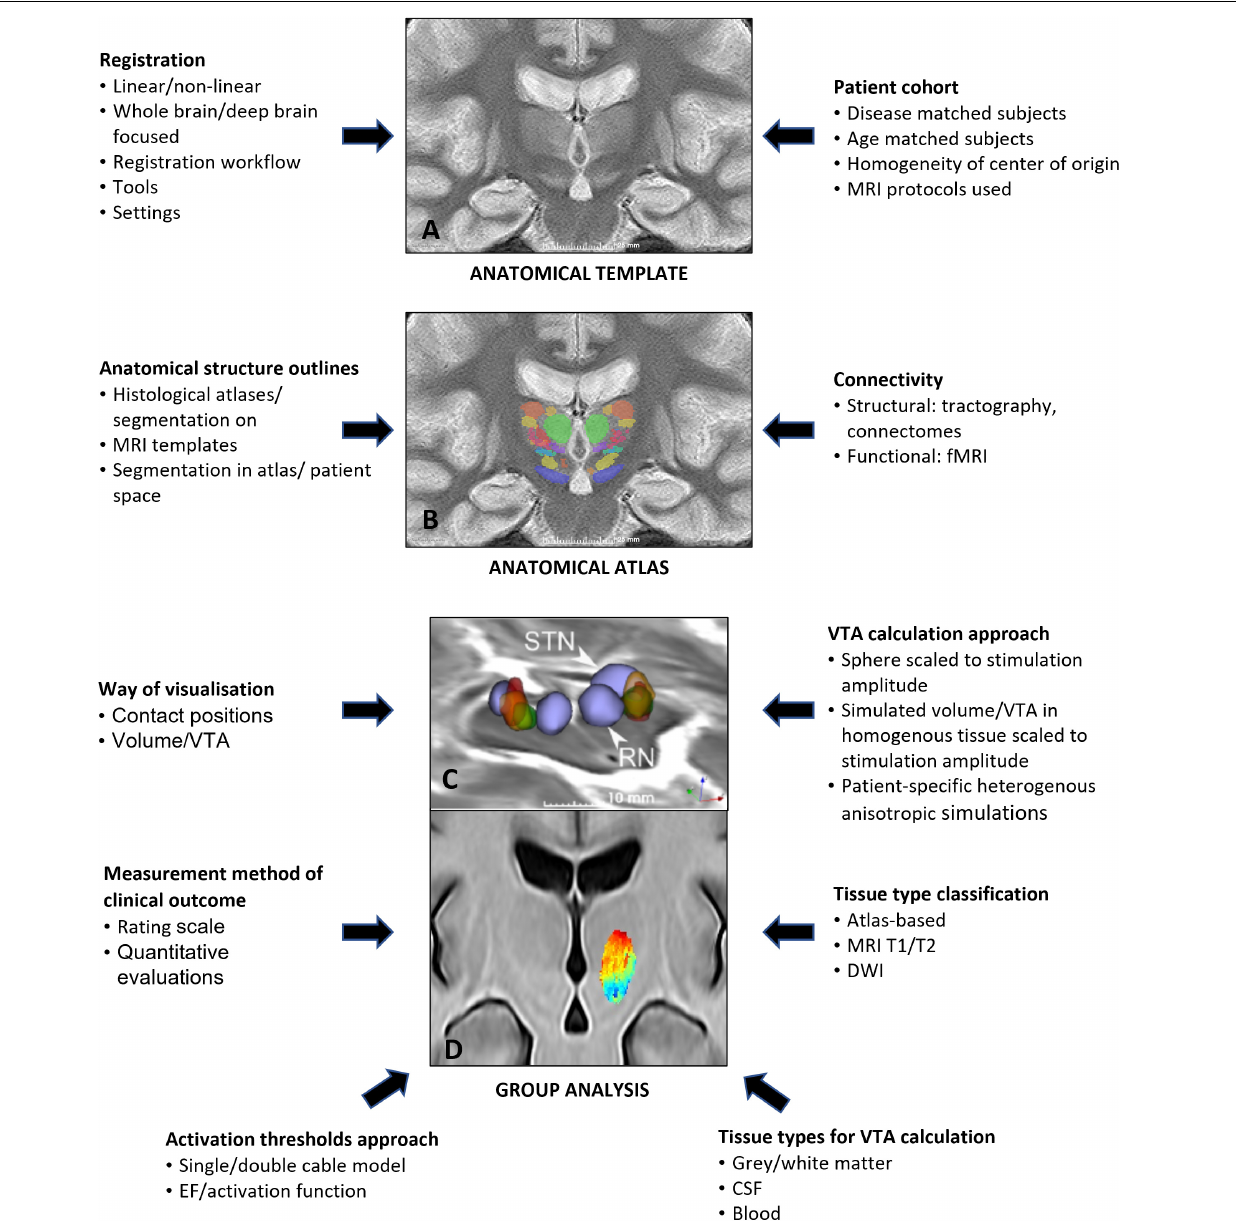
FIGURE 8 | Example of a deep brain anatomical template alone (A) , an anatomical atlas with structural information projected on the anatomical template (B) and stimulation atlases with stimulation maps from patient cohorts projected on the anatomical template for group analysis (C,D) . Parameters that can influence the different steps are noted on the left and right